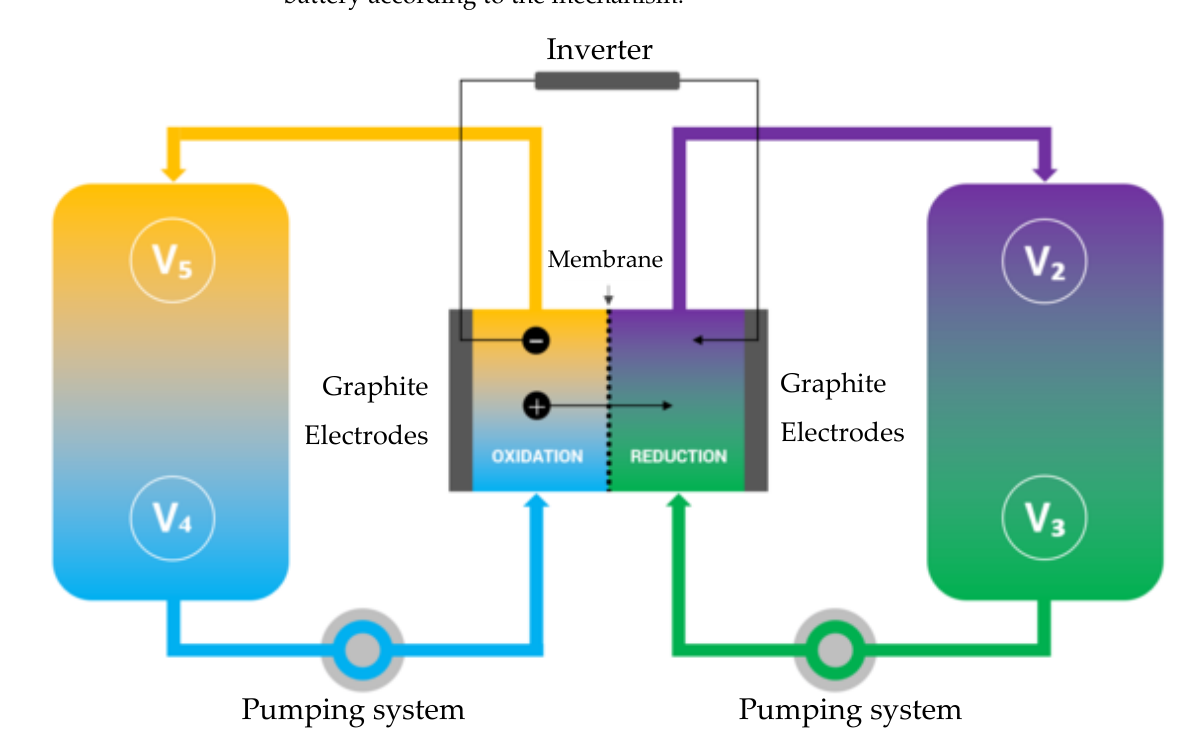
Figure 1. VRFB cell: V 2 —discharged cathode electrolyte V 2+ : V 3 —charged cathode electrolyte V 3+ ; V 4 —discharged anode electrolyte V 3+ : V 5 —charged anode electrolyte V 5+ .